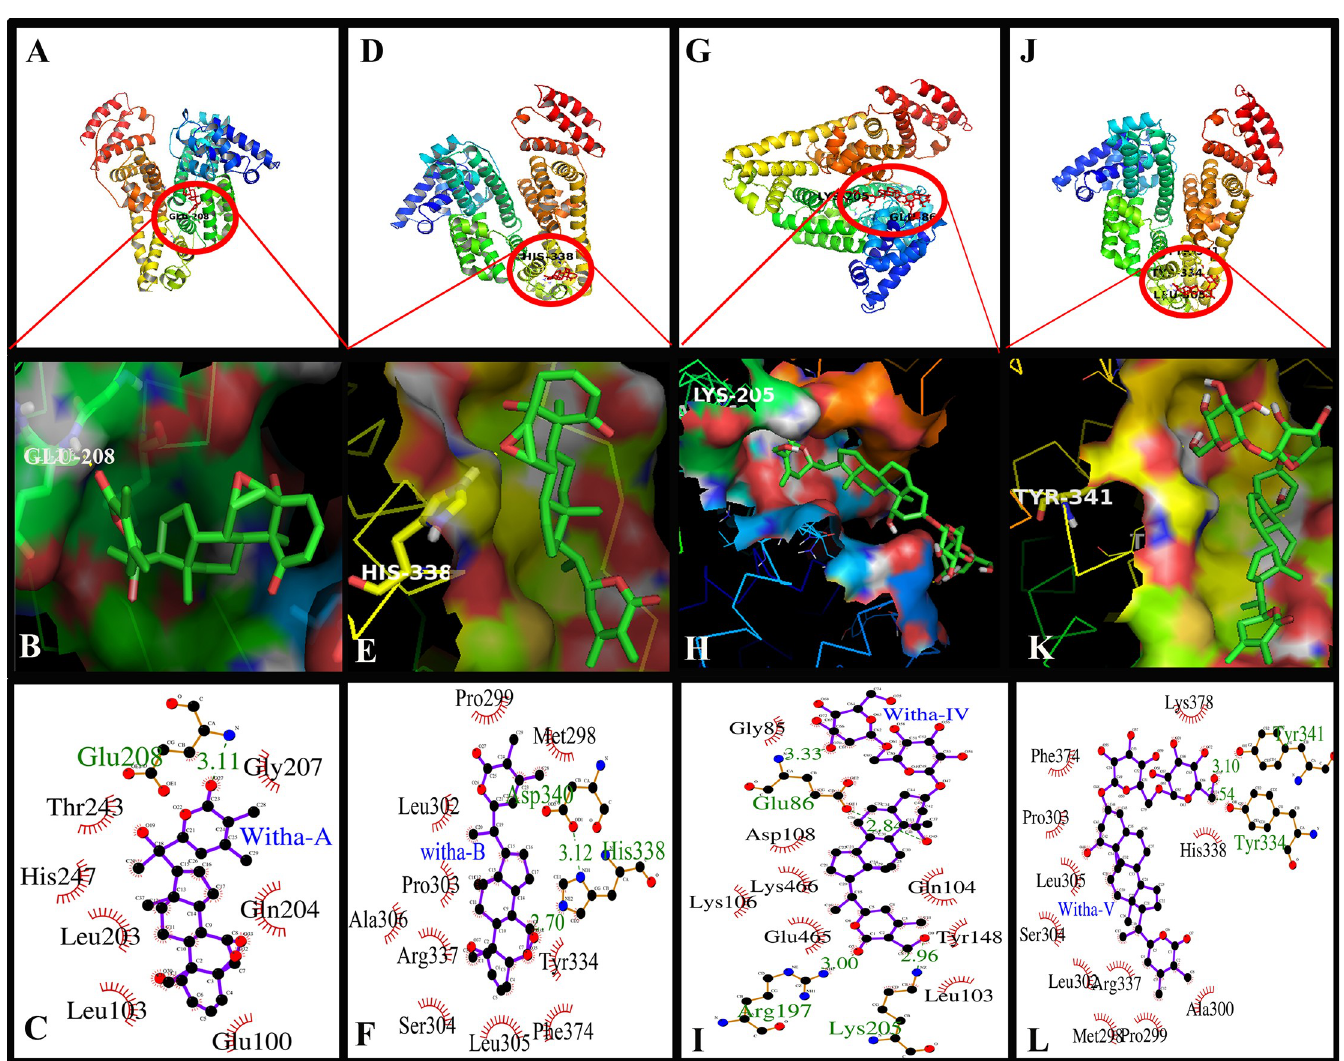
Fig 7. Molecular docking studies between HSA and withanolide A, withanolide B, withanoside IV and withanoside V showed that the minimum binding energy conformer is very close to the experimentally determined values. (A, D, G, J) Cartoon model of HSA showing withanolide derivatives A, B, IV and V docked in the binding pocket using Autodock 4.2. (B, E, H, K) Pymol generated images showing withanolide A, withanolide B, withanoside IV and withanoside V binding in their specific binding site of HSA. The cavity of hydrophobic and hydrophilic amino acid residues surrounding the probe. (C, F, I, L) Ligplot showing the hydrophobic interactions of HSA with withanolide